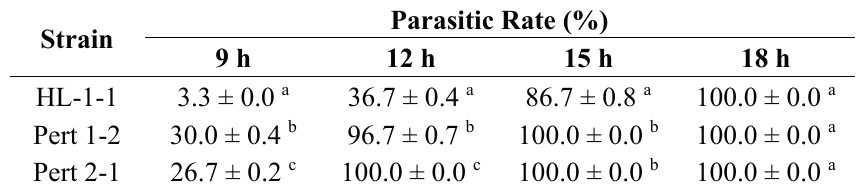
Table 2. Parasitism of C. rosea f. catenulata HL-1-1 and Per3 gene transformants on the sclerotia of S. sclerotiorum .